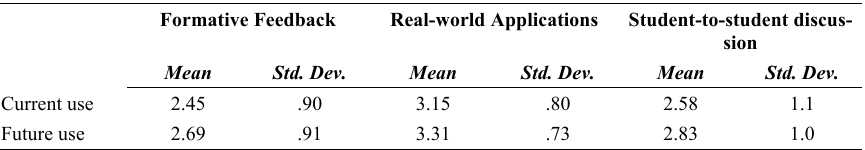
Table 2. Current and future use of specific classroom strategies